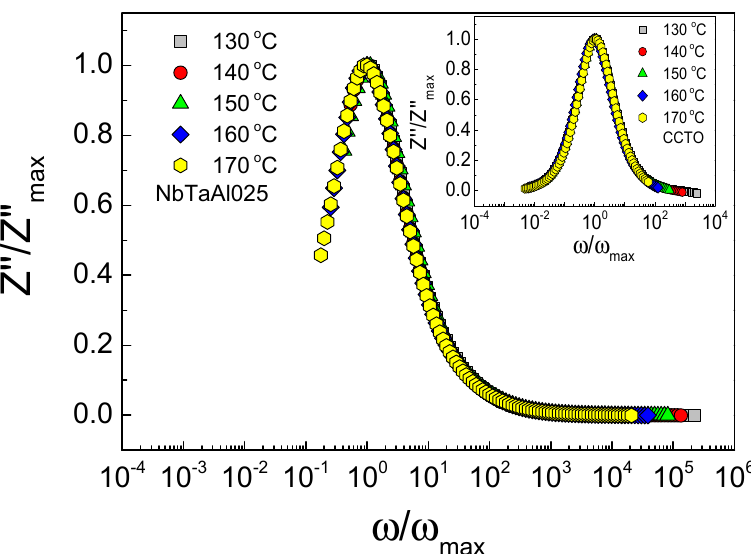
Figure 6. Scaling behavior of Z ″ of the NbTaAl05 ceramic in the temperature range from 130 to 170 °C; its inset shows scaling behavior of Z ″ of the CCTO sample.